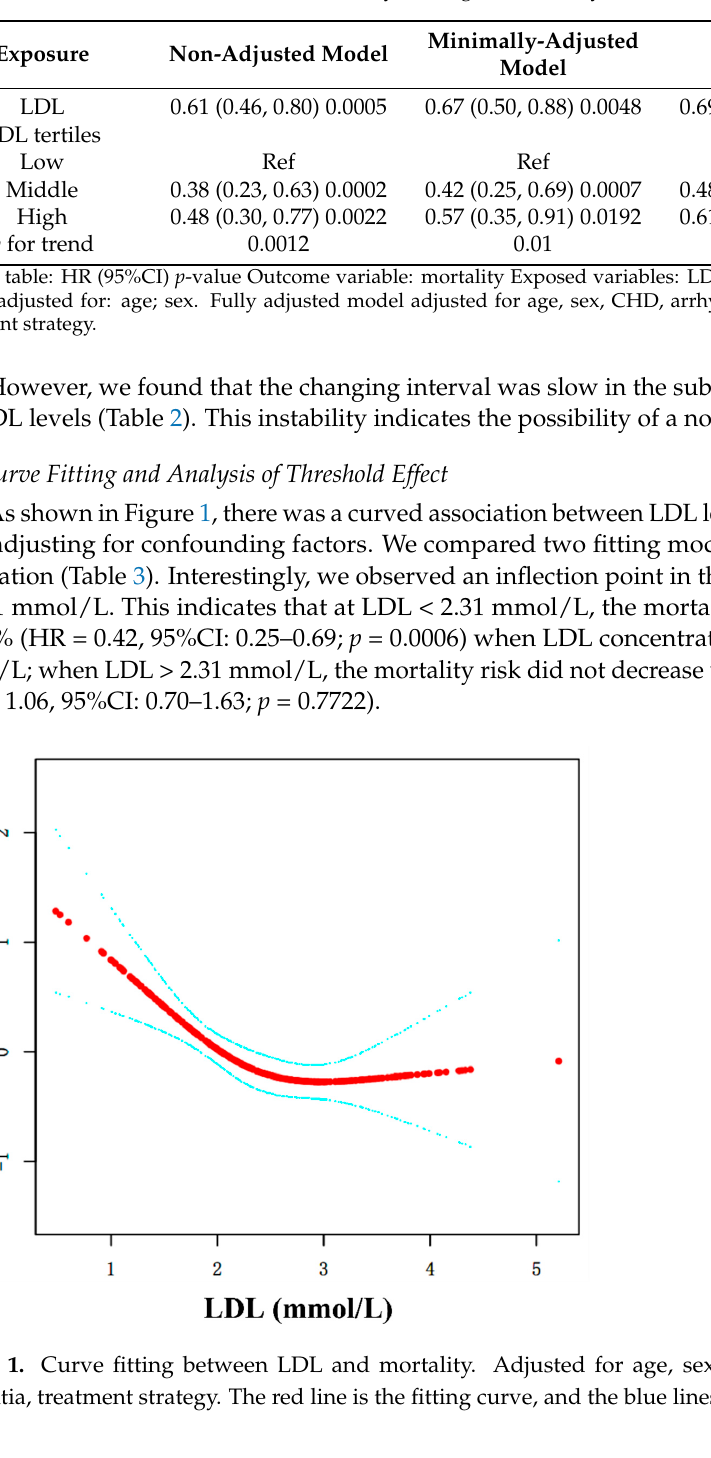
Table 2. Univariate and multivariate results by cox regression analyses.